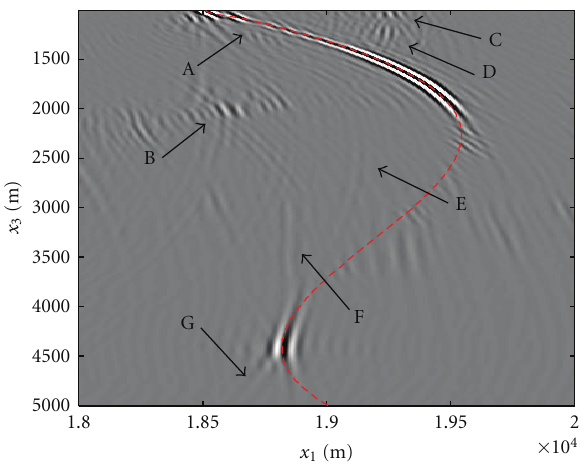
Figure 30: Reference response (black) and the correlation function (red) for a virtual source at x A = (15000m,4000m) in a model with varying source spectra and a gas cloud; reflections 1, 2, and 3 are indicated.